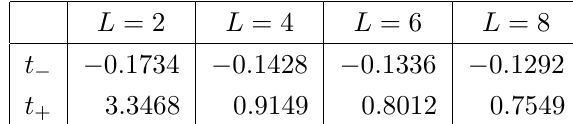
Figure 1 . Plot of branches 1, 2, 3 and 4 corresponding to the e(cid:11)ective tachyon potential at levels ( L; 3 L ) with L =2,4,6 and 8, in Siegel gauge.